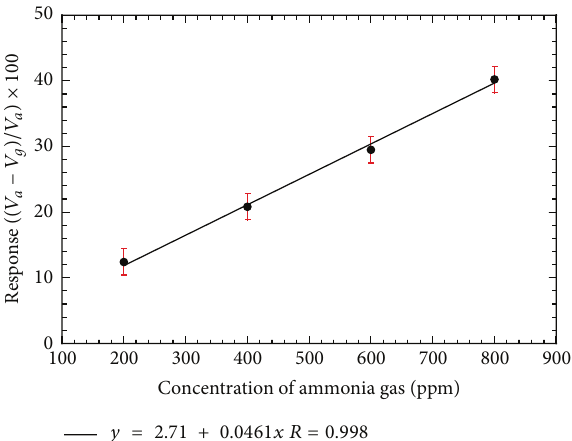
Figure 4: Linear correlation between response and ammonia gas concentration of gas sensor based on BCG-PEDOT:PSS.